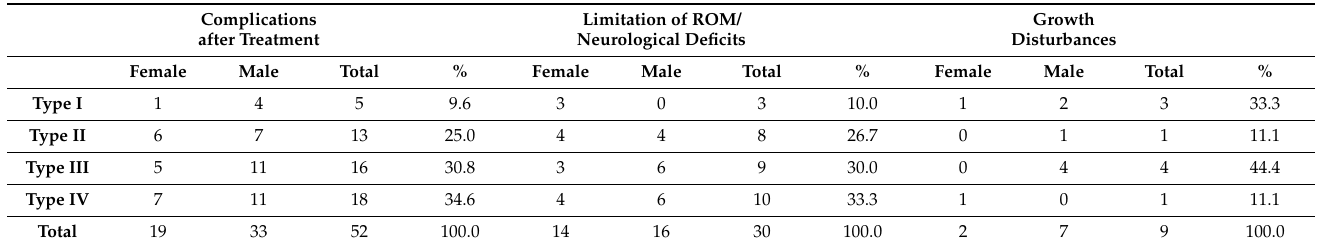
Table 6. Gender distribution concerning adverse events and fracture